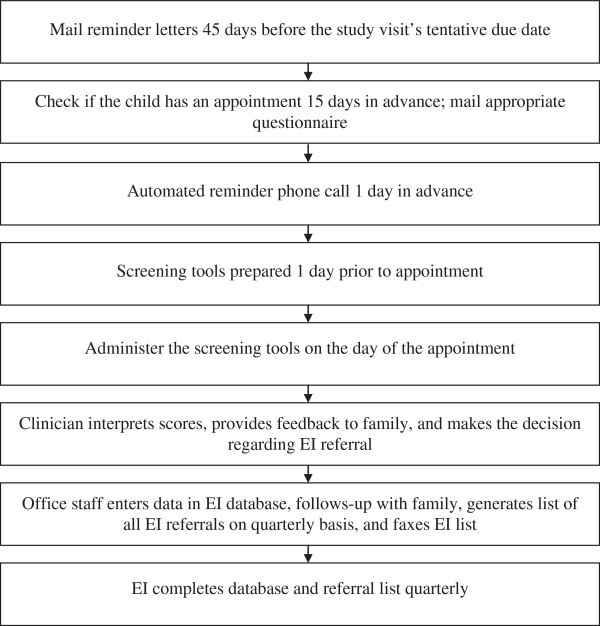
Workflow procedures.